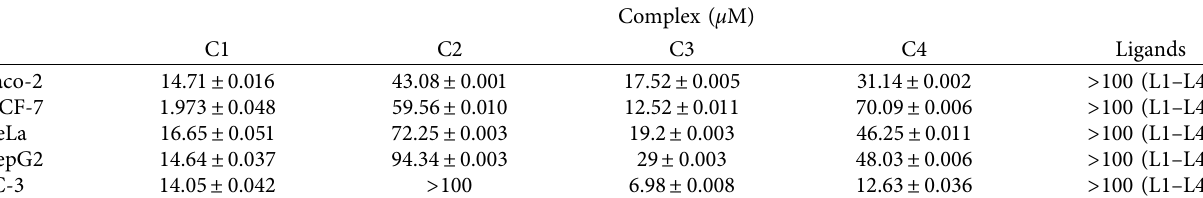
on the d-d transitions, as the DNA concentration is serially increased to a solution of a metal complex. Binding modes are then inferred from the spectra, whereby an intercalative mode results in a hypochromic shift and bathochromic shift or 3.4. DNA-Binding Studies. Spectroscopy is widely used in the hypsochromism. Intercalation is as a result of overlap of π ∗ study of binding modes for metal complexes by observing the antibonding orbitals of the ligands bound to the complex with alterations that appear in the λ absorption values of π - π ∗ π bonding orbitals of the DNA base pairs. This decreases the max intraligand transitions, ligand ⟶ metal charge transfers, or probable transitions, and the effect is observed as